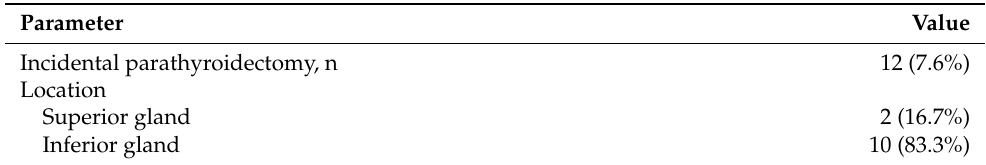
Table 3. Incidentally removed parathyroid glands: incidence, location, cause, and associated thyroid condition.